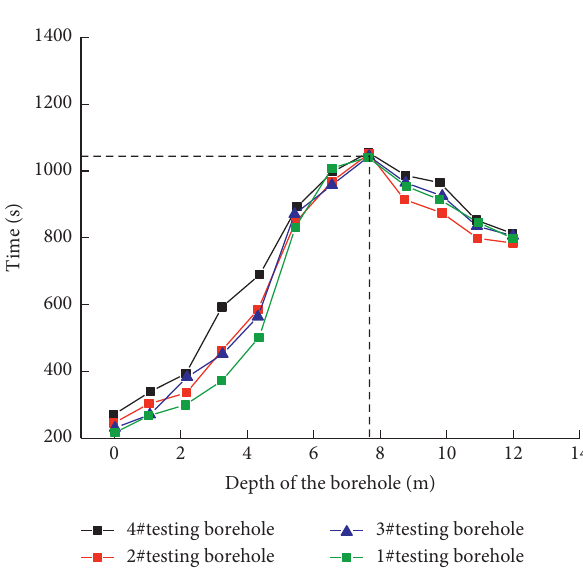
Figure 13: Curves of drilling time against rate of